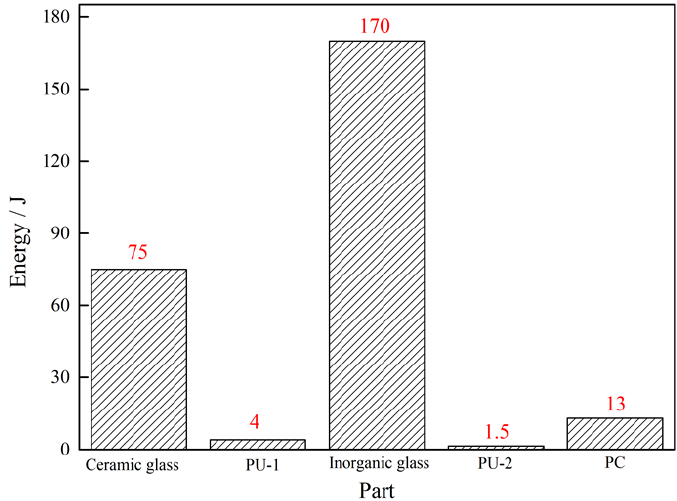
Figure 10. The mechanical energy of each part at 20 ms after the projectile hits.